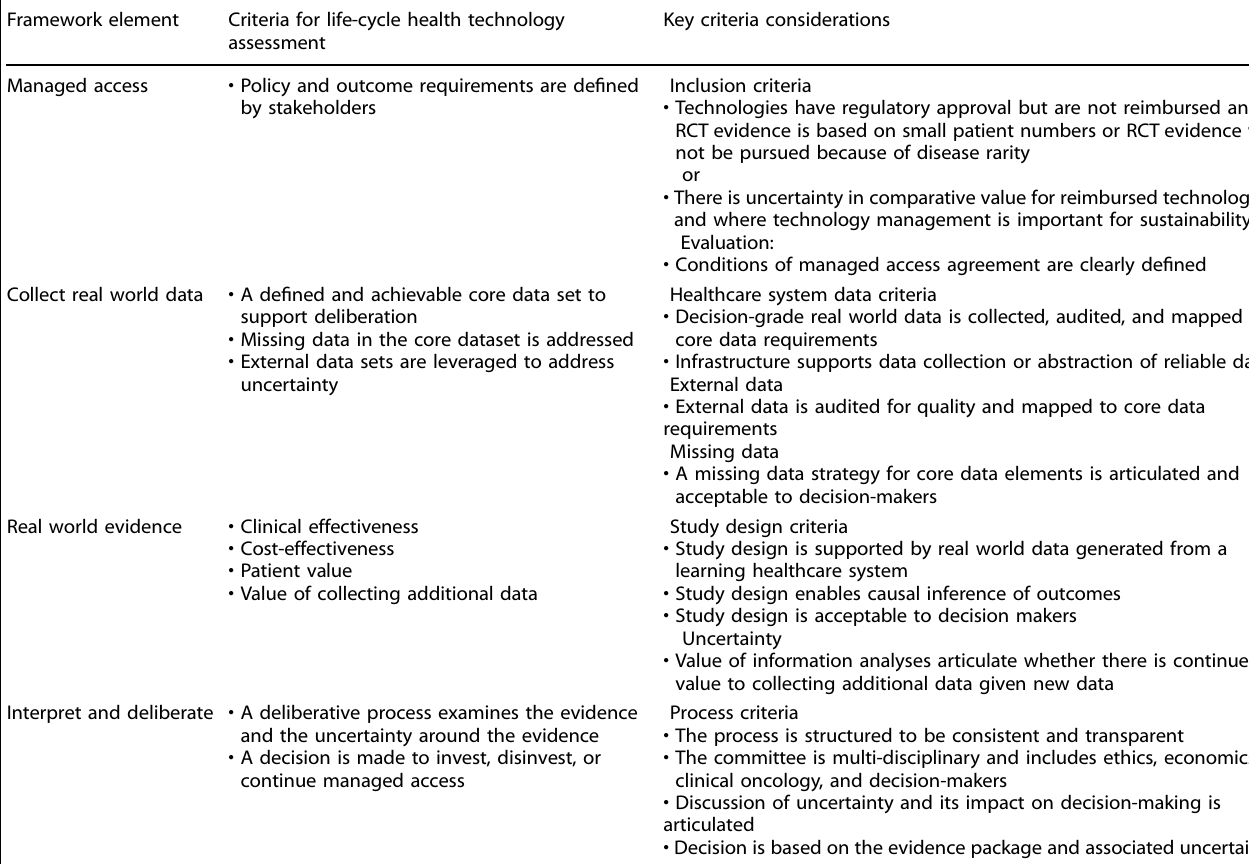
Table 1. Criteria and key considerations for a life-cycle health technology assessment approach to precision oncology. Framework